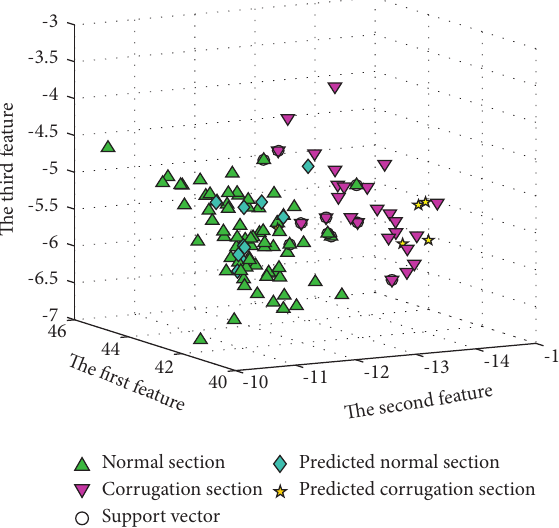
Figure 15: The prediction result of the SVM classifier using CEEMD-STFT